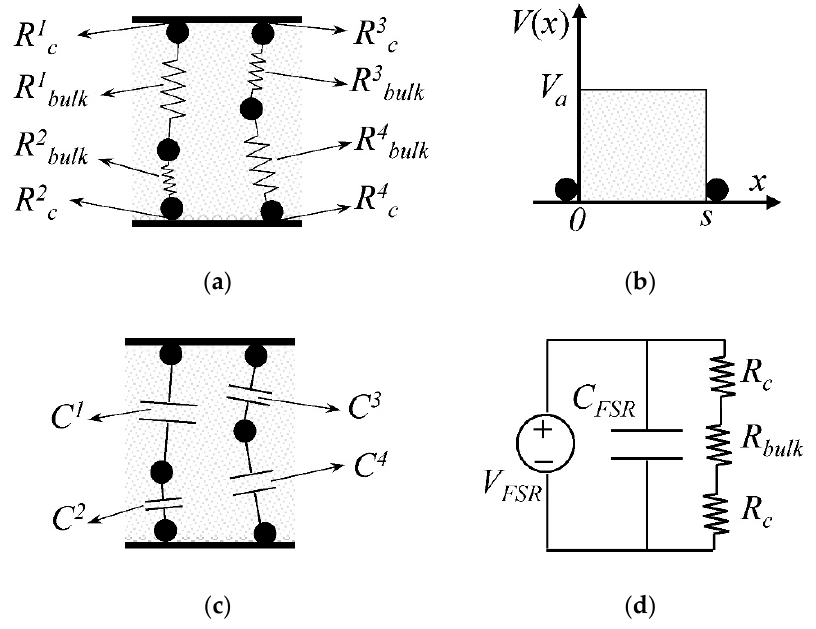
Figure 1. The electric model of FSRs. ( a ) Sketch of the lumped resistances in an FSR representing the contact resistances ( R ic ) and the tunneling resistances ( R ibulk ); ( b ) representation of the tunneling resistance between two conductive particles separated by a potential barrier of height V a and width s ; ( c ) Sketch of the lumped capacitances ( C i ) in an FSR; ( d ) Macroscopic model of an FSR connected to an external driving voltage ( V FSR ), where R c and R bulk represent the net contact and tunneling resistances, respectively. The symbol C FSR matches for the net capacitance of the FSR.